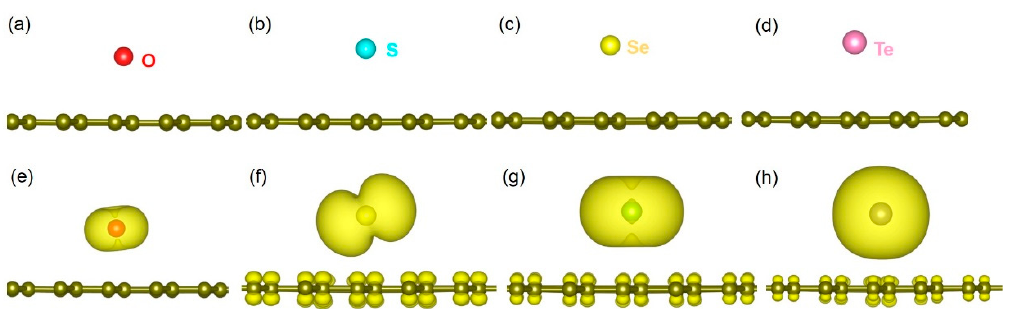
Figure 3 . Initial configurations ( a – c ) of a dopant atom adsorbed onto the surface of pristine graphene.